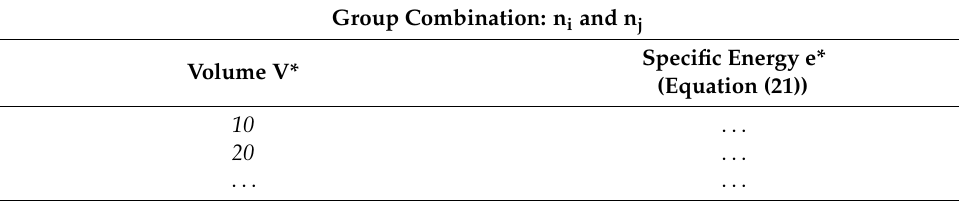
Table 3. Calculation of the convex hyperbola for a certain group